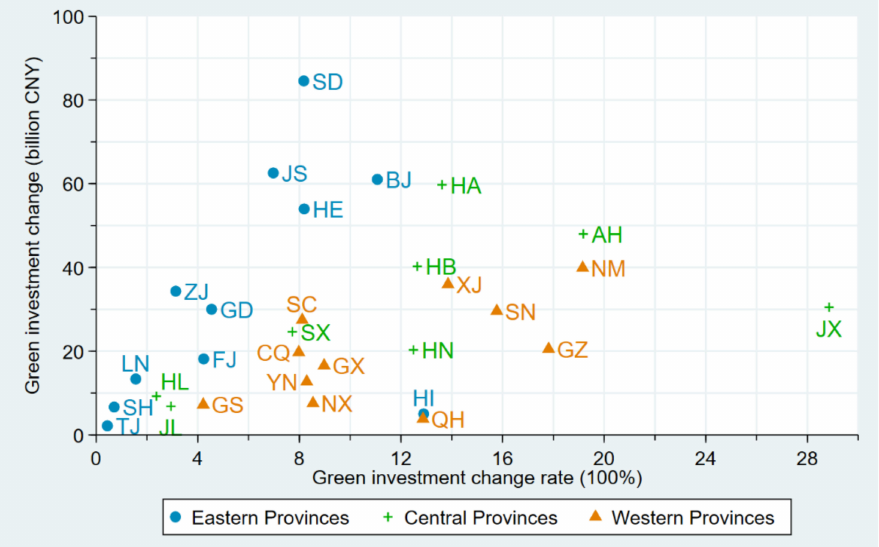
Figure 2. Provincial green investment change and green investment change rate in China during